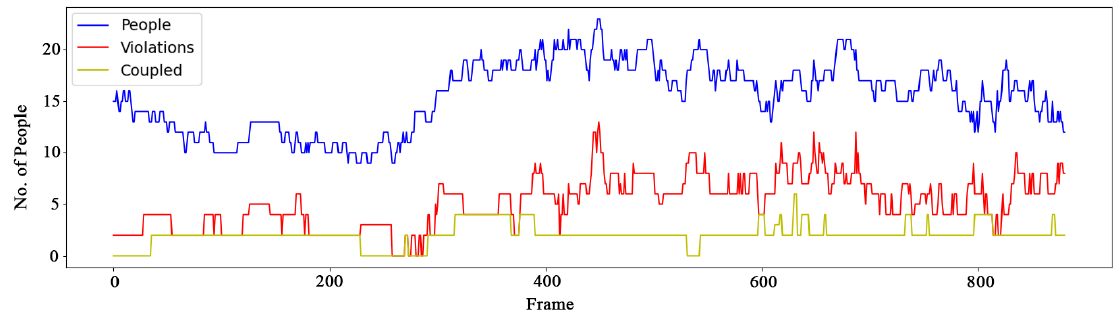
Figure 15. A 2D recording of the number of detected people in 900 frames from the OTC Dataset, as well as the number of violations and number of couples with no